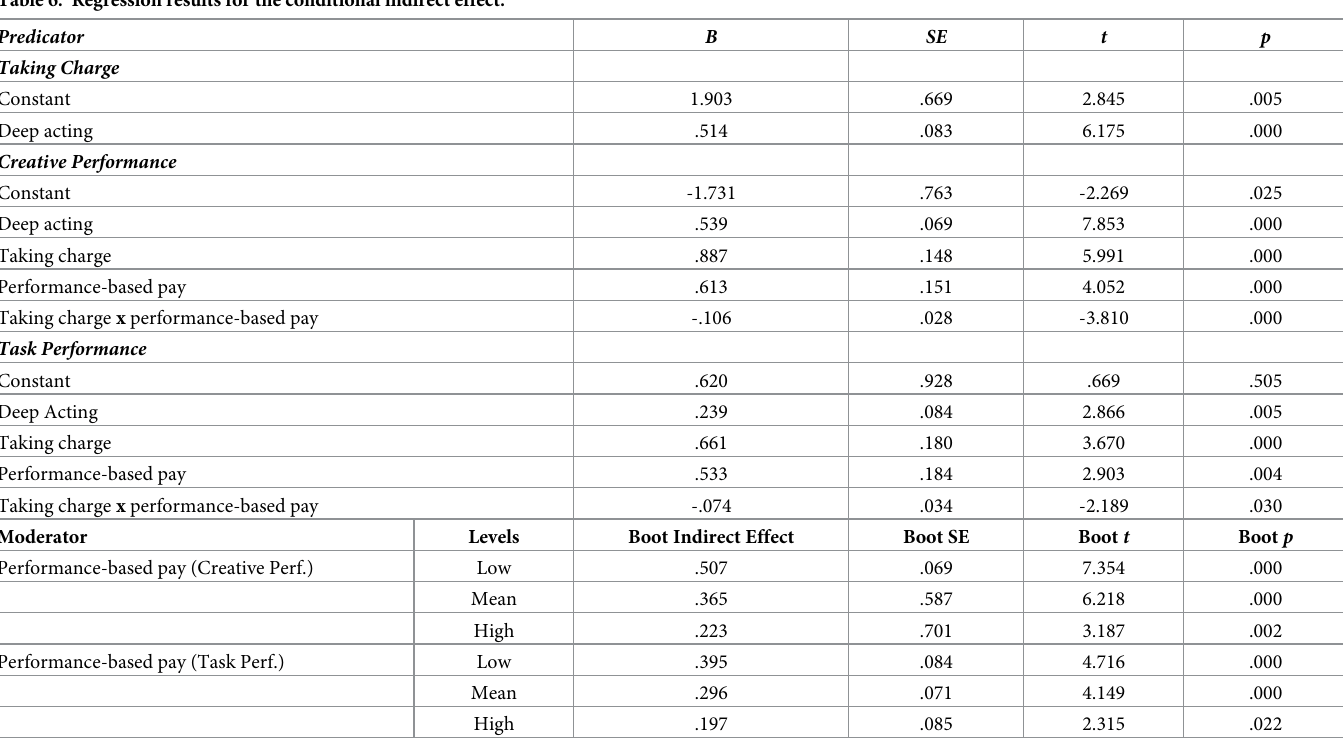
Table 6. Regression results for the conditional indirect effect. Predicator